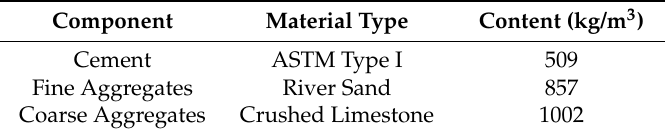
Table 1. Concrete mix design (kg/m 3 ).